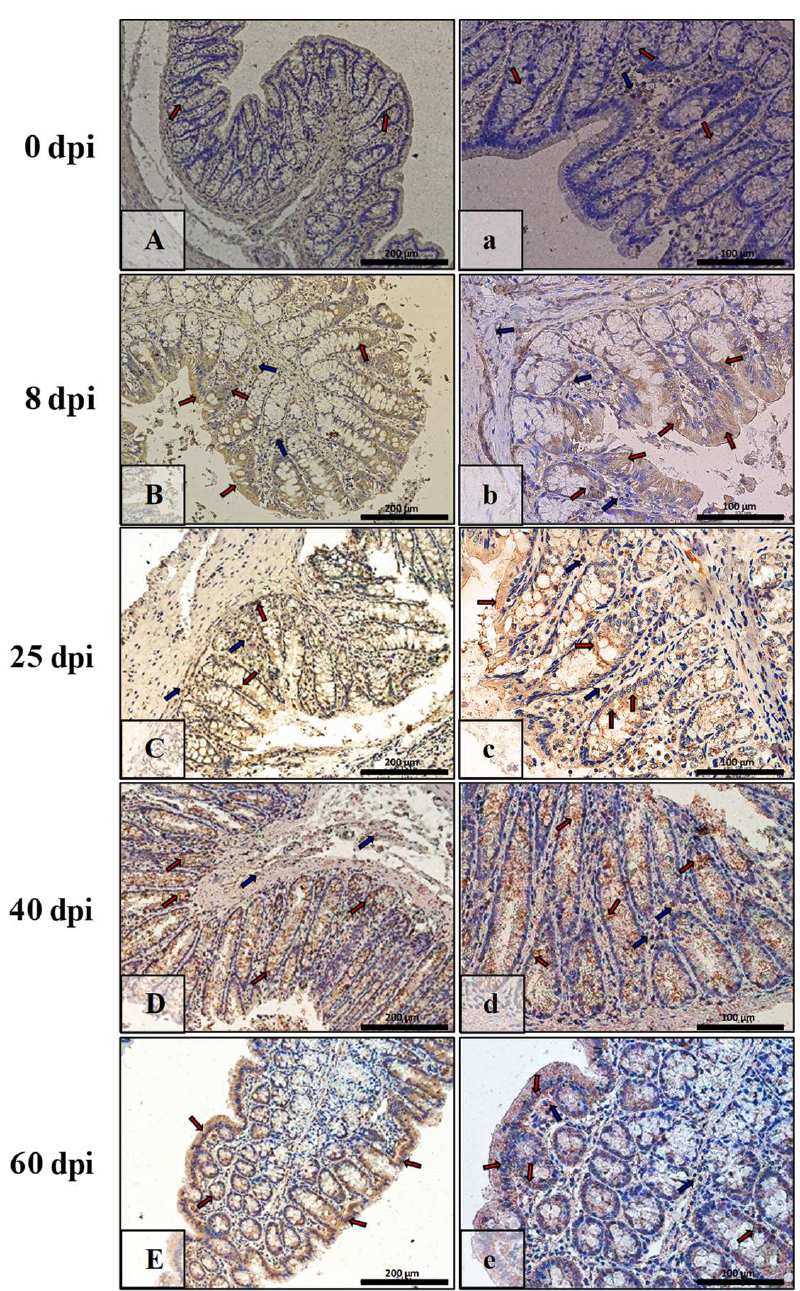
Figure 14. Representative microphotographs showing caspase-9 immunoexpression in the colon of control animals ( A , a ) and on consecutive days ( B , b , C , c , D , d , E , e ) after H. diminuta infection. Positive IHC reaction—brown reaction indicated by arrows: red—epithelial cells of the intestinal villi and crypts, blue—cells in the connective tissue lining of the mucosa. Lens magnification: ×20 ( A – E , scale bar: 200 μm), ×40 ( a – e , scale bar: 100 μm).